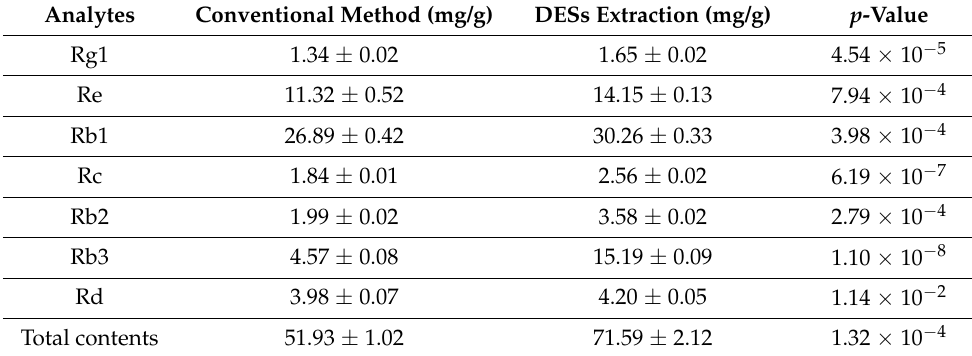
Table 3. The contents of seven compounds by using different extraction methods.